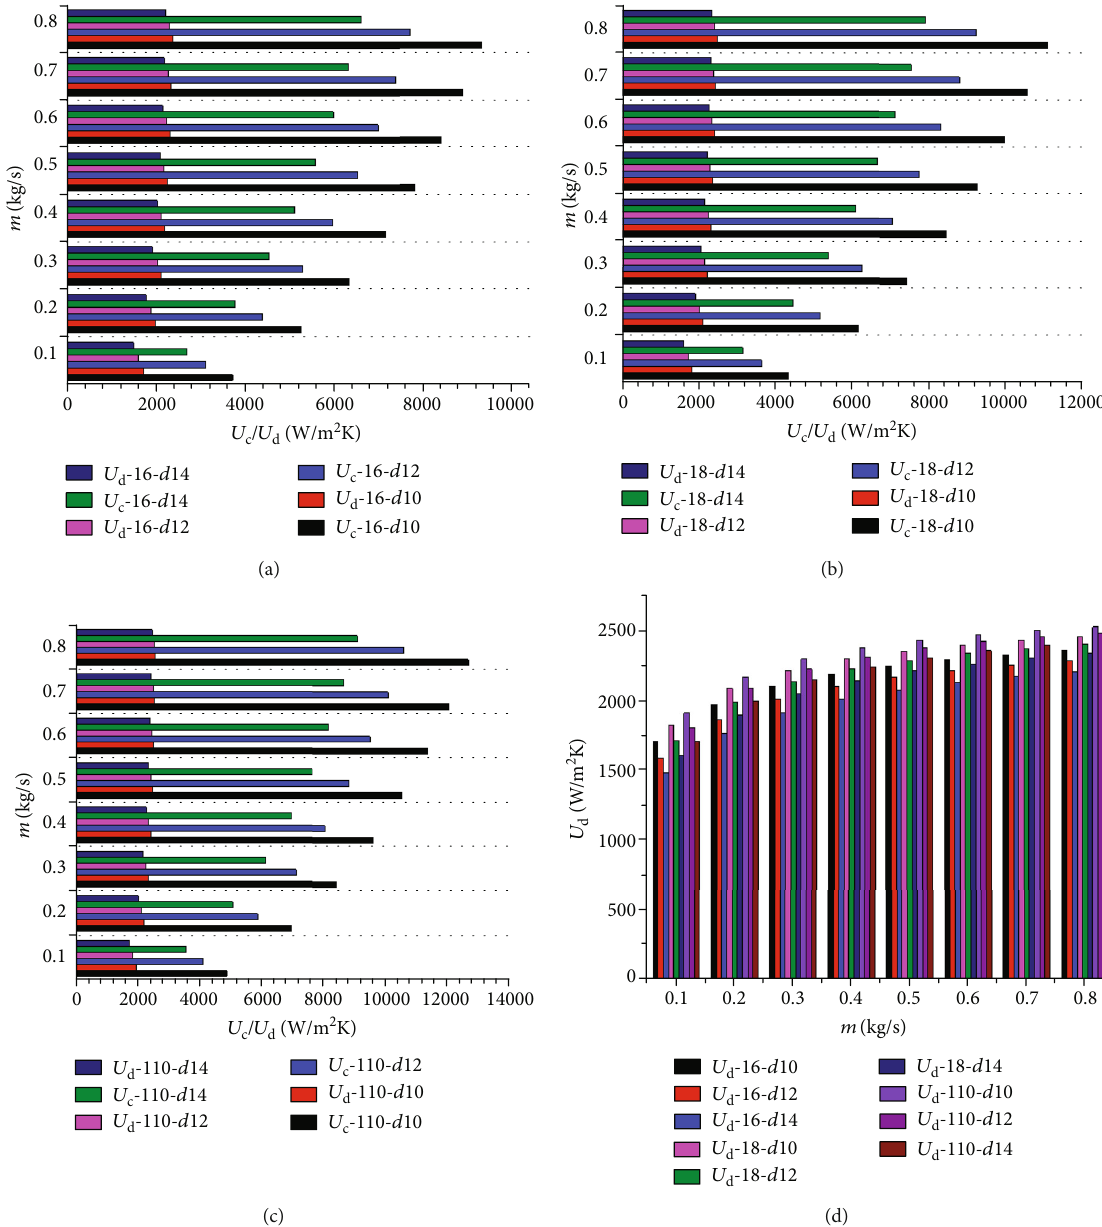
Figure 5: Overall heat transfer coe ffi cient versus mass fl ow rate: (a) 600 mm length, (b) 800mm length, (c) 1000 mm length, and (d) design overall heat transfer coe ffi cient among all con fi